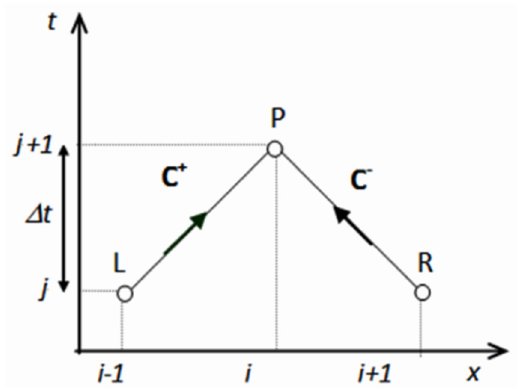
Figure 5. Characteristic lines in x – t